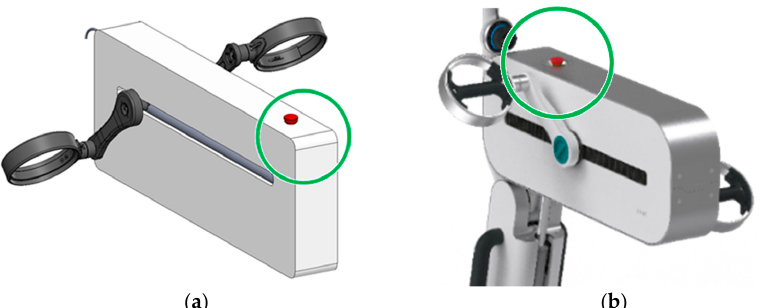
Figure 8. From the left: ( a ) The Original LEPRE Carter; ( b ) the carter of the LEPRE Rehabilitation Device in the CE marked version.